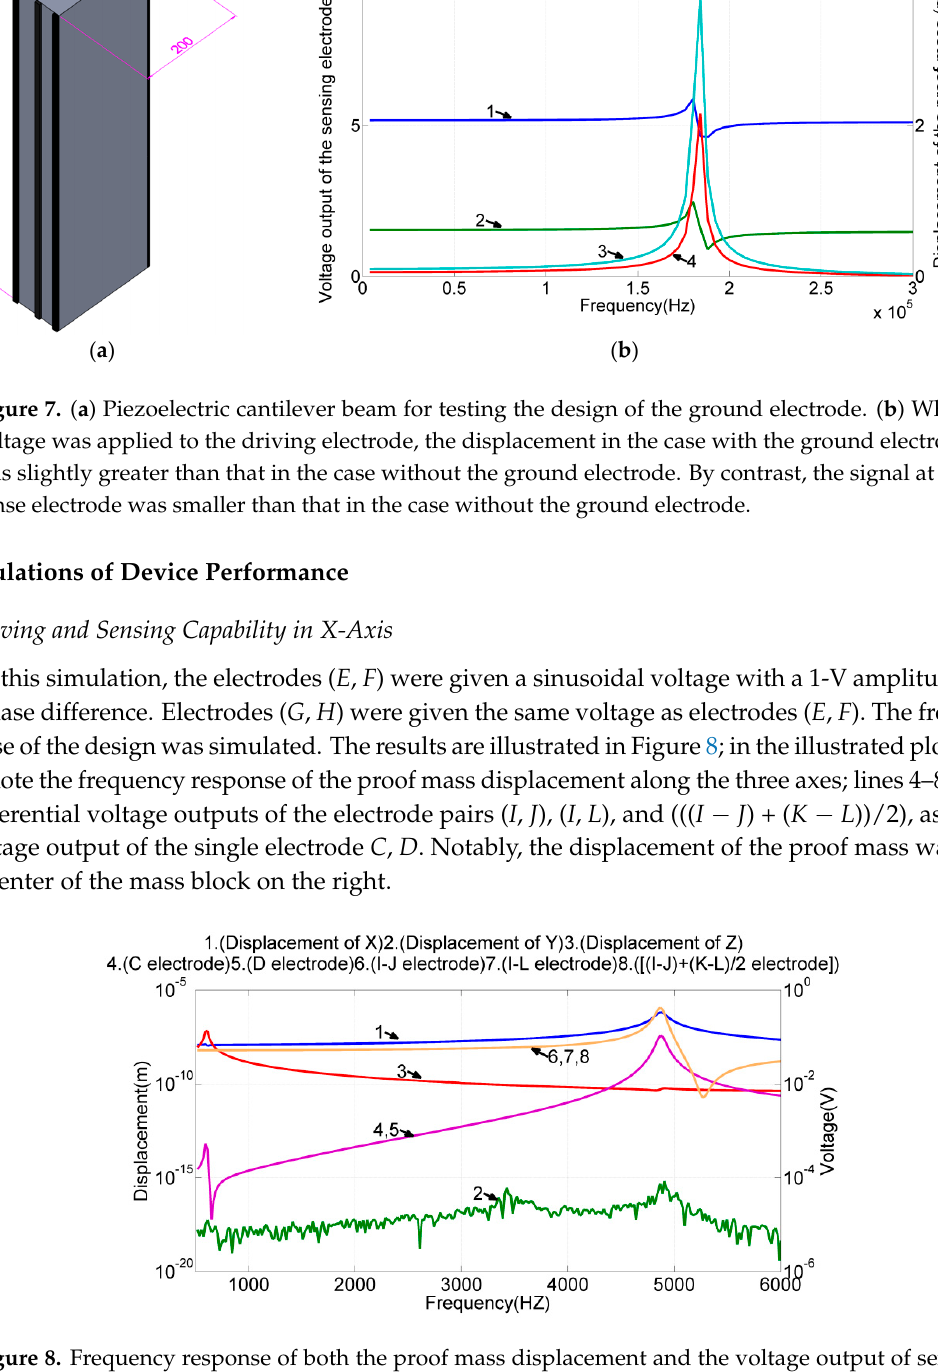
Figure 8. Frequency response of both the proof mass displacement and the voltage output of sense electrodes when the device was actuated by drive electrodes ( E , F , G , H ).